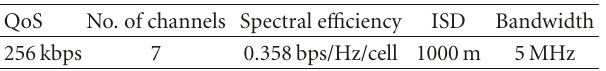
Table 3: Capacity values for QPSK single resolution, CDMA scheme for 5 MHz